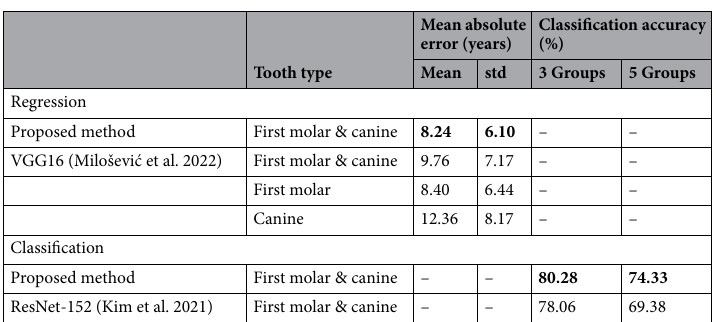
Table 4. Results of experiment to compare the performances of proposed methods, including regression and classification methods. Significant values are in